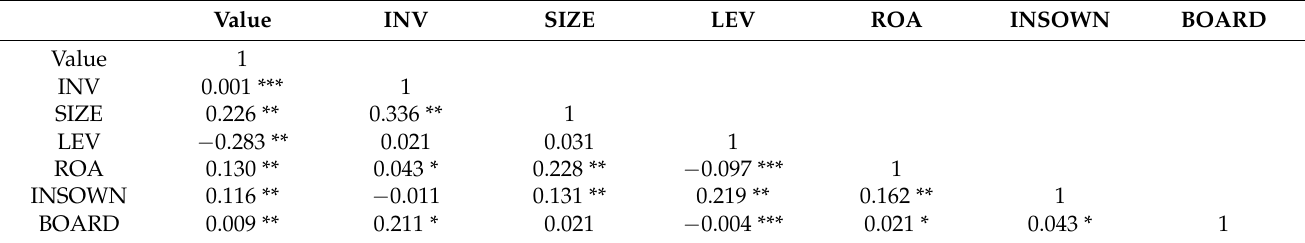
Table 2. Correlation analysis of research variables.